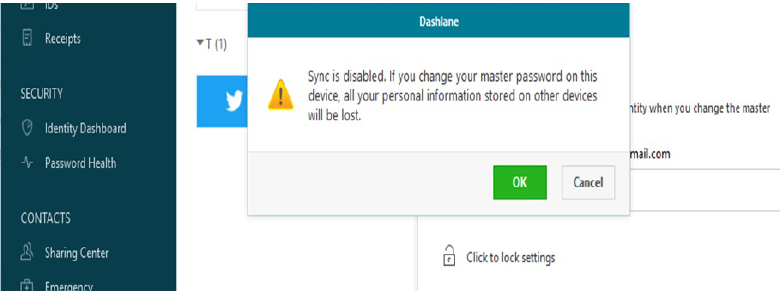
Figure A20. Changing the master password while synchronization is disabled causes a loss of data stored on other devices.